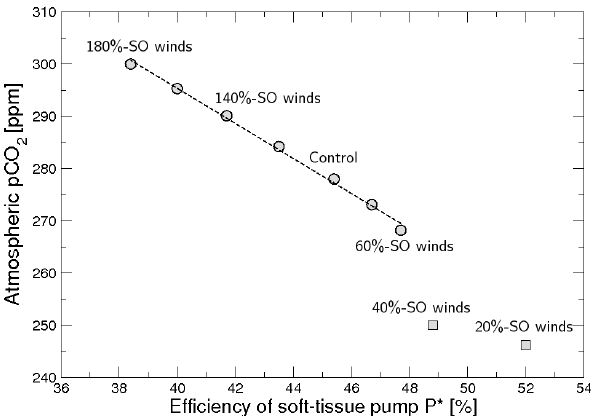
Fig. 8. Ocean ventilation experiments: quasi-linear relation be- tween simulated atmospheric CO 2 and the efficiency of the soft- tissue pump P ∗ (Ito and Follows, 2005) for the ventilation states with active NADW formation (circles). The linear relation is per- turbed when NADW formation is shutdown in response to strongly reduced windstress in the Southern Ocean